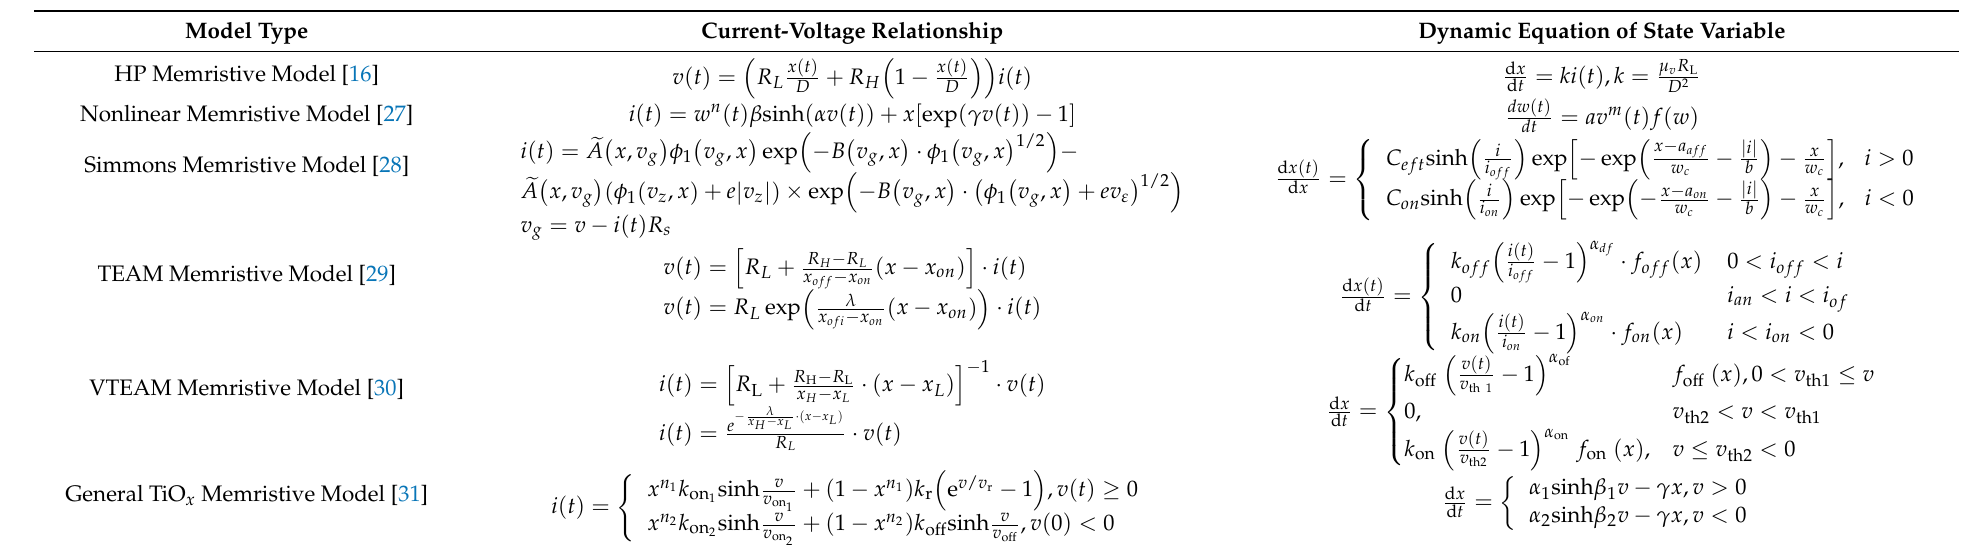
Table 1. Mathematical models of memristors.